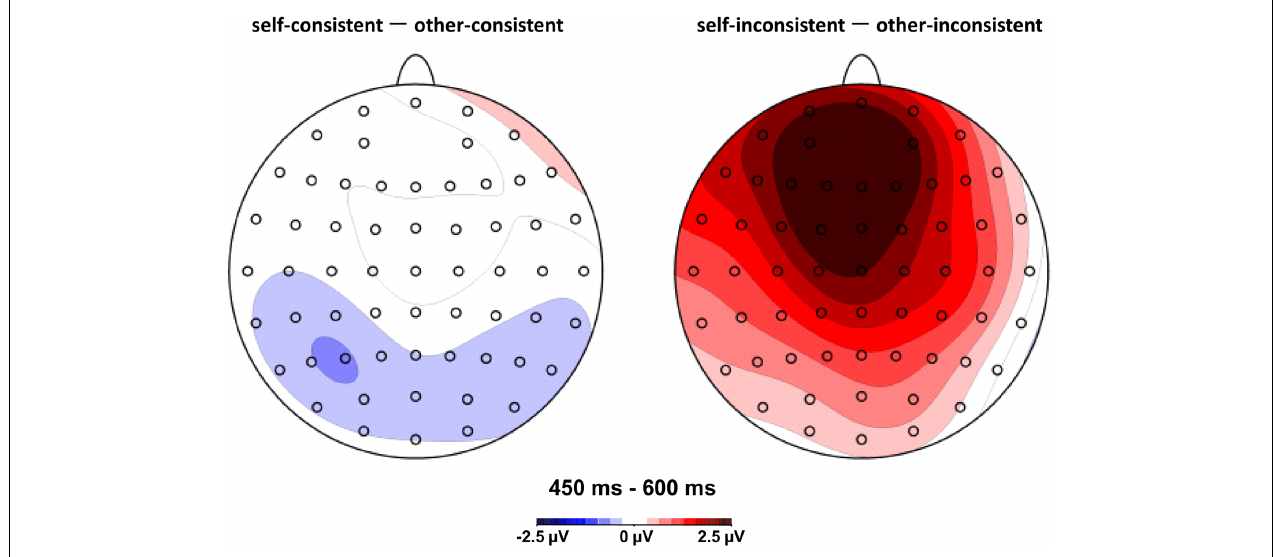
FIGURE 3 | Topographic maps of difference waves: other-consistent condition subtracted from self-consistent condition (left panel), and other-inconsistent condition subtracted from self-inconsistent condition (right panel) in the 450–600 ms post-stimulus